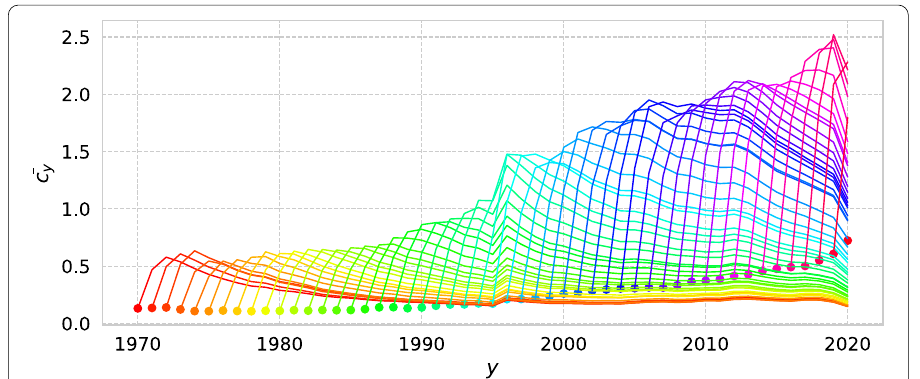
Fig. 5 Distribution of citation in each year for all papers. Each coloured line refers to the average number of citation published in dotted point. Although citation inflation increases the citations to papers submitted in recent years, it does not increase the number of citations to older